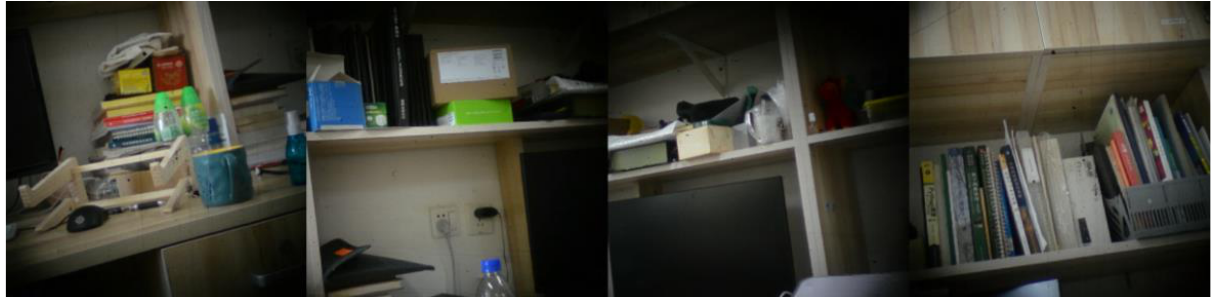
Figure 17. Sample images of scene 1.